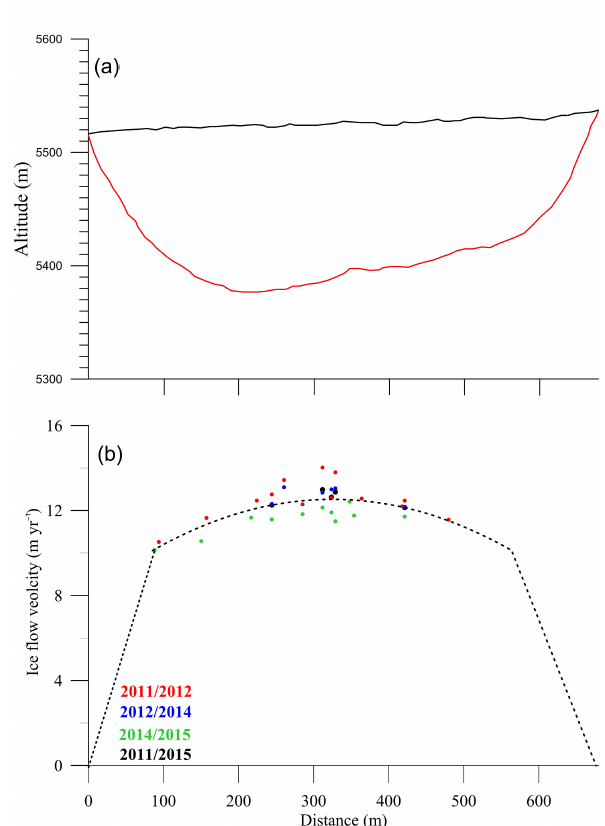
Figure 4. (a) Cross section of glacier thickness derived from GPR measurements at profile M on 25 October 2011. (b) Measured sur- face velocities across section M over the period 2011–2015.The dashed line corresponds to a second order polynomial function us- ing all the measurements and forced linearly to zero at the right and left